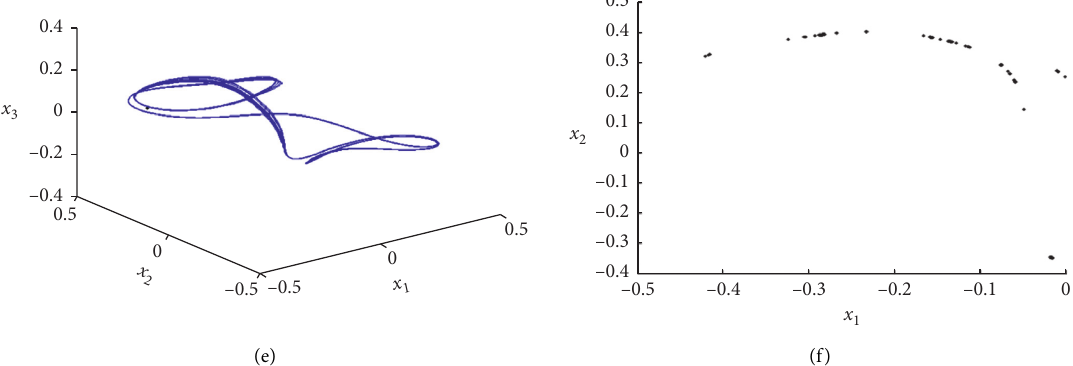
Figure 16: The quasi-periodic oscillation of the cantilevered pipe conveying pulsating fluid is obtained when the external excitation is F � 6 . 3. (a) Phase portrait on plane ( x ( t, x ) , (e) three-dimensional phase portrait in space ( x 3